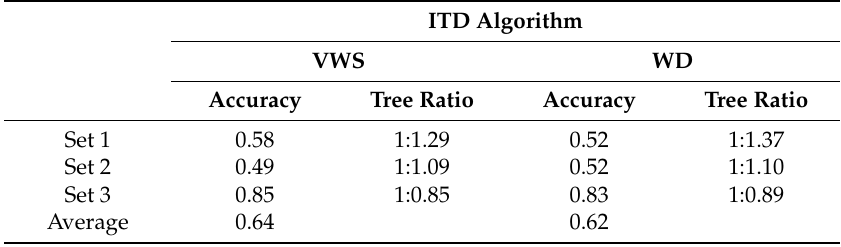
Table 6. Verification results of the ITD algorithms for the three datasets.